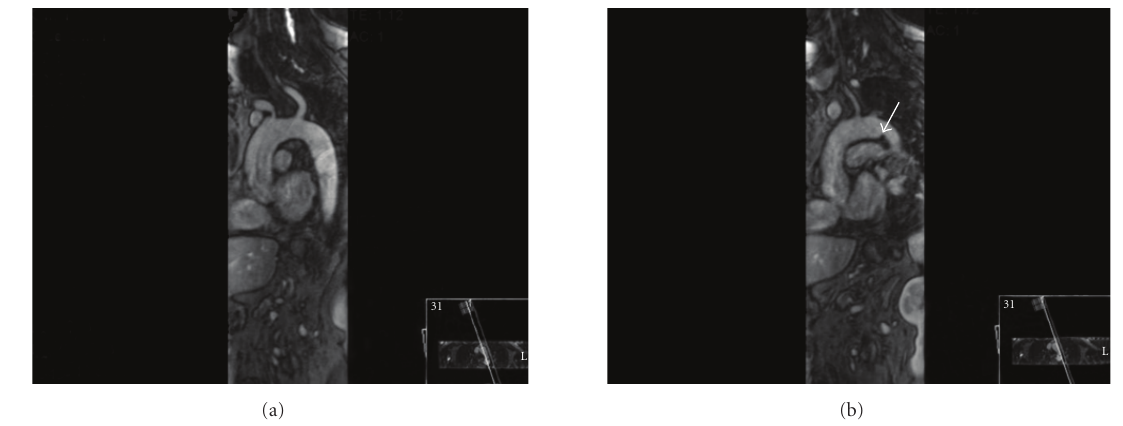
Figure 3: Thoracic MRI performed before surgery, showing normal dimensions of the thoracic aorta (a) and a repletion defect ( arrow ) in the aortic arch-descending thoracic aorta transition compatible with a vegetation